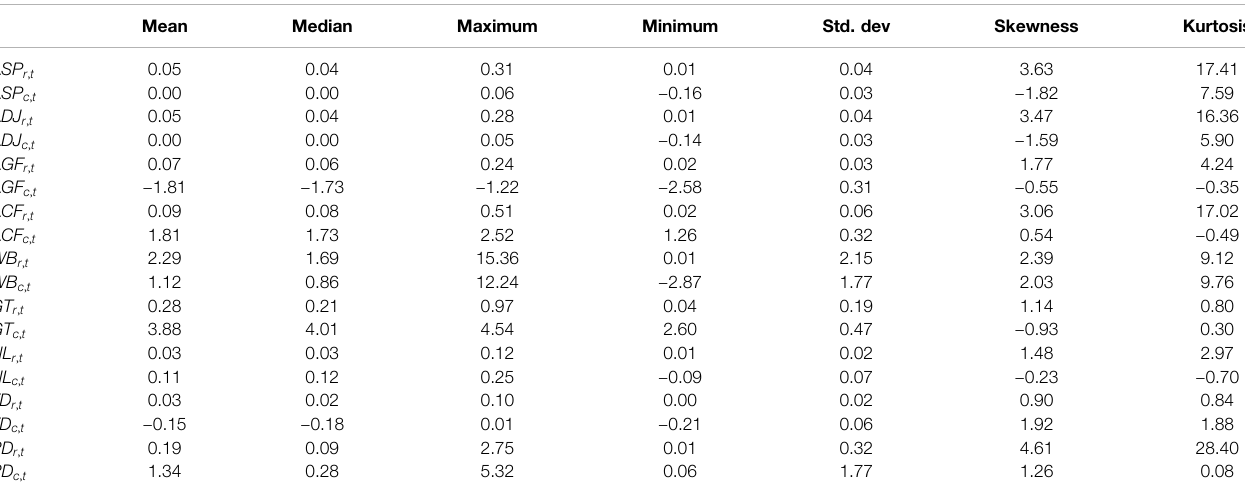
TABLE 3 | Basic statistical analysis on monthly interval-valued explanatory